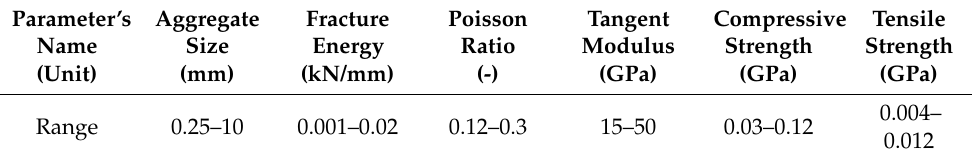
Table 9. Range of values of concrete parameters used in the